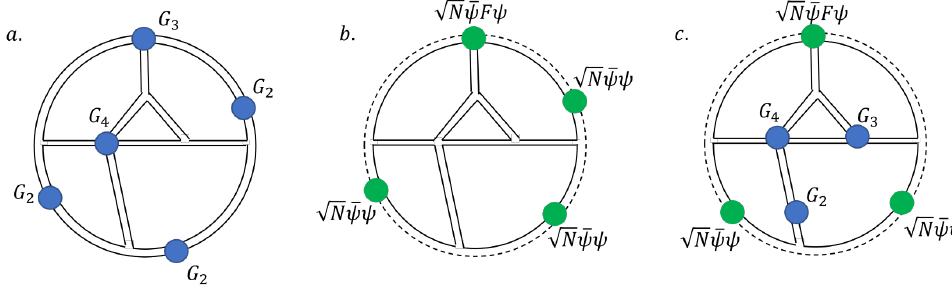
Figure 2 . Diagrams with insertions of glueballs (in blue) and mesons (in green). The solid and dashed lines represent colour and flavour indices respectively. Every insertion reduces the number of vertices by 1 or increases the number of propagators by 1. In any case, this gives a factor of 1 /N . √ In addition, a meson insertion comes with a factor of N due to the normalization. This gives the rules described in the text: an n -point function of glueballs scales as N 2 − n , as shown in diagram a ; an n -point functions of mesons scales as N 1 − n/ 2 , as shown in diagram b ; and a mixed correlator of n G glueballs and n M mesons scales as N 1 − n G − n M / 2 , as shown in diagram c